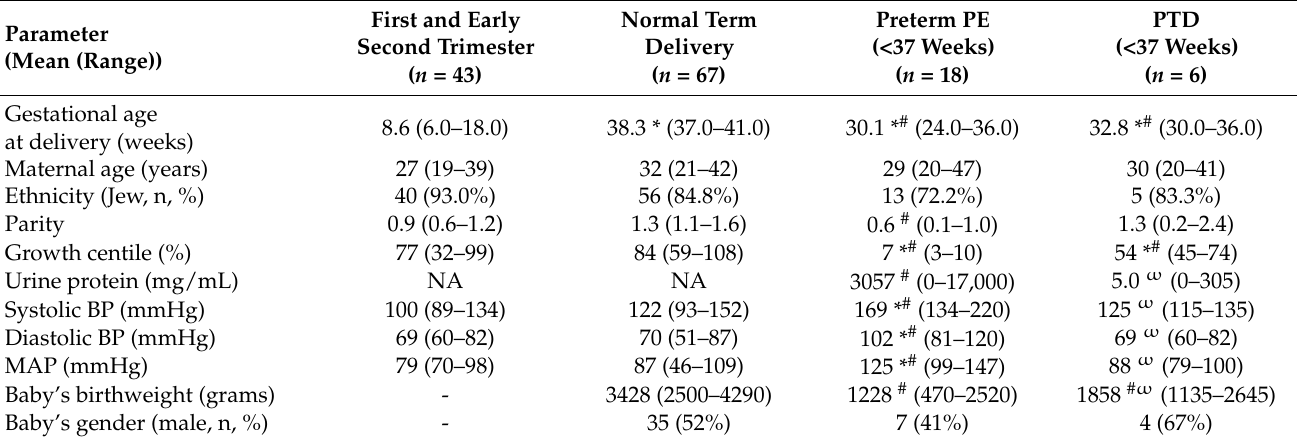
Table 1. Demographic and pregnancy characterization—Israelian cohort.